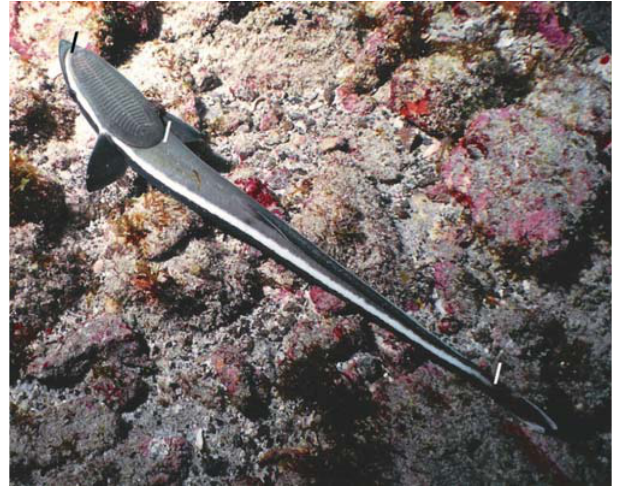
Fig. 3 Sharksucker ( Echeneis naucrates ) resting on a reef, show- ing relative size of sucking disk, body shape, proportions, and color pattern. Bars mark sucking disk and standard lengths. Photo taken at Fernando de Noronha, courtesy D.